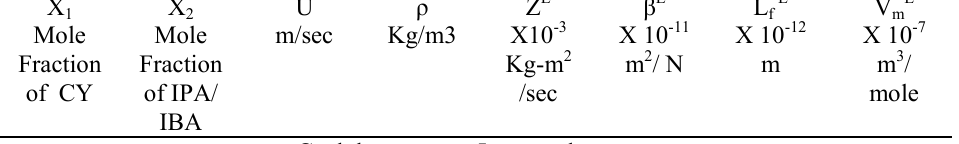
Table 1. Experimental values of ultrasonic velocity (U), density (ρ) and excess acoustical impedance (Z E ), excess adiabatic compressibility ( β E ), excess free length (L